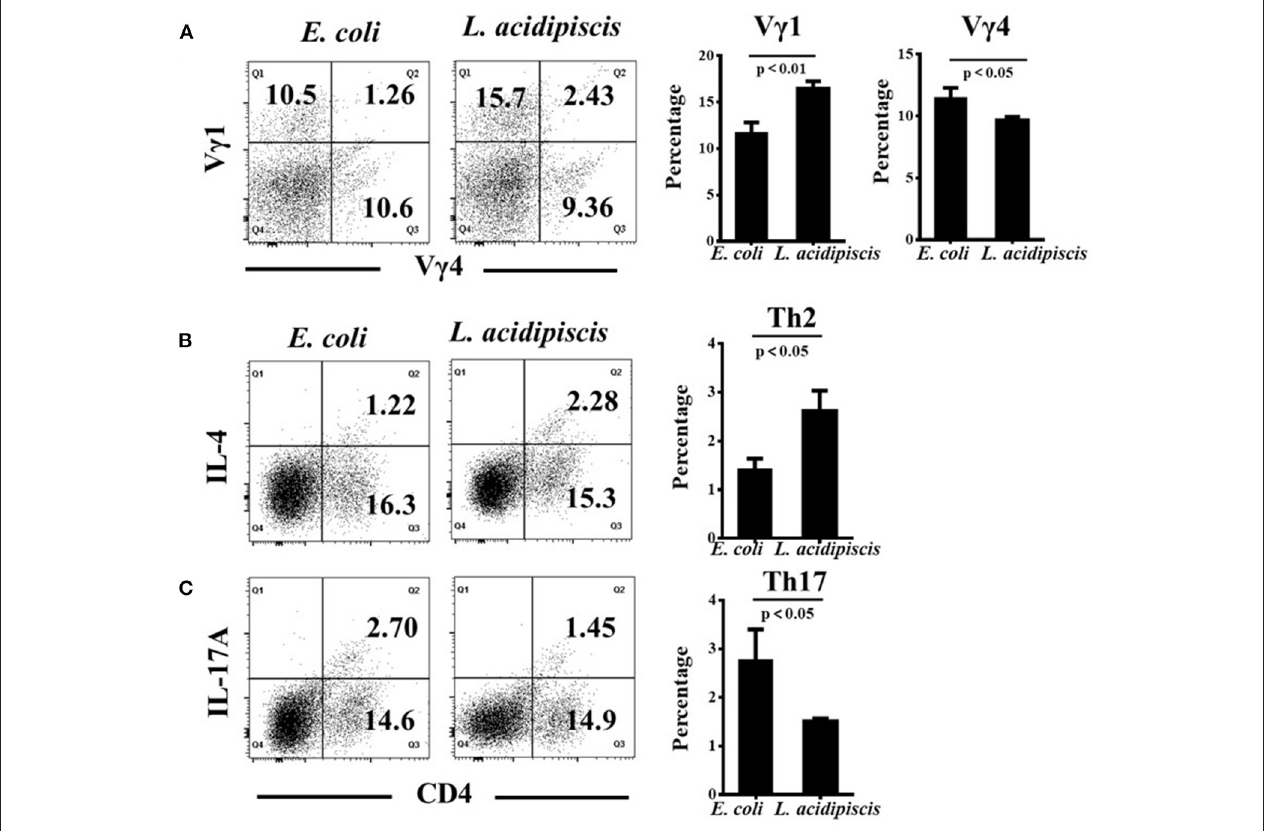
FIGURE 6 | L. acidipiscis promoted the development of V γ 1 + γδ T cells and inhibited V γ 4 + γδ T cells in vitro . (A) The development of V γ 1 + γδ T cells was significantly enhanced while the development of V γ 4 + γδ T cells was significantly suppressed after they were co-cultured with L. acidipiscis . (B) The development of Th2 cells was significantly enhanced after they were co-cultured with L. acidipiscis . (C) The differentiation of Th17 cells was significantly inhibited after co-cultured with L. acidipiscis . Representative flow cytometry plots were derived from a single experiment with three mice per experimental group and average percentage of each subset was expressed as mean ± SEM from three independent experiments. Data were analyzed with Student’s t -test, and data with P < 0.01, P < 0.05 represent significant differences between the two